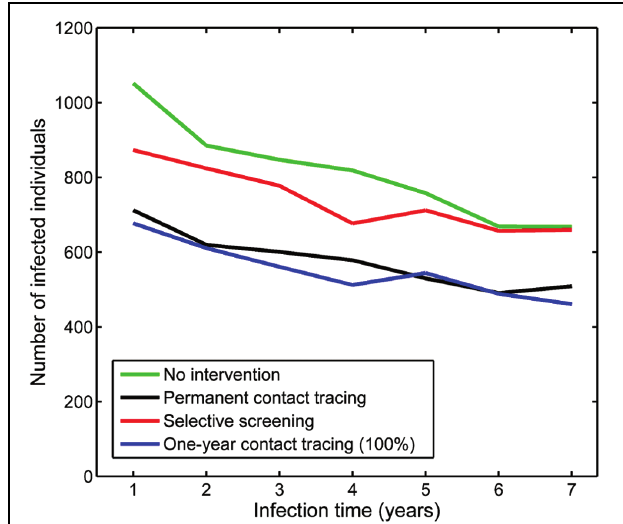
FIGURE 9 | Effect of the different tested screenings on the evolution of the infected time distribution observed in virtual experiments after 10 simulated years. All of them started with a homogeneous distribution of 4,500